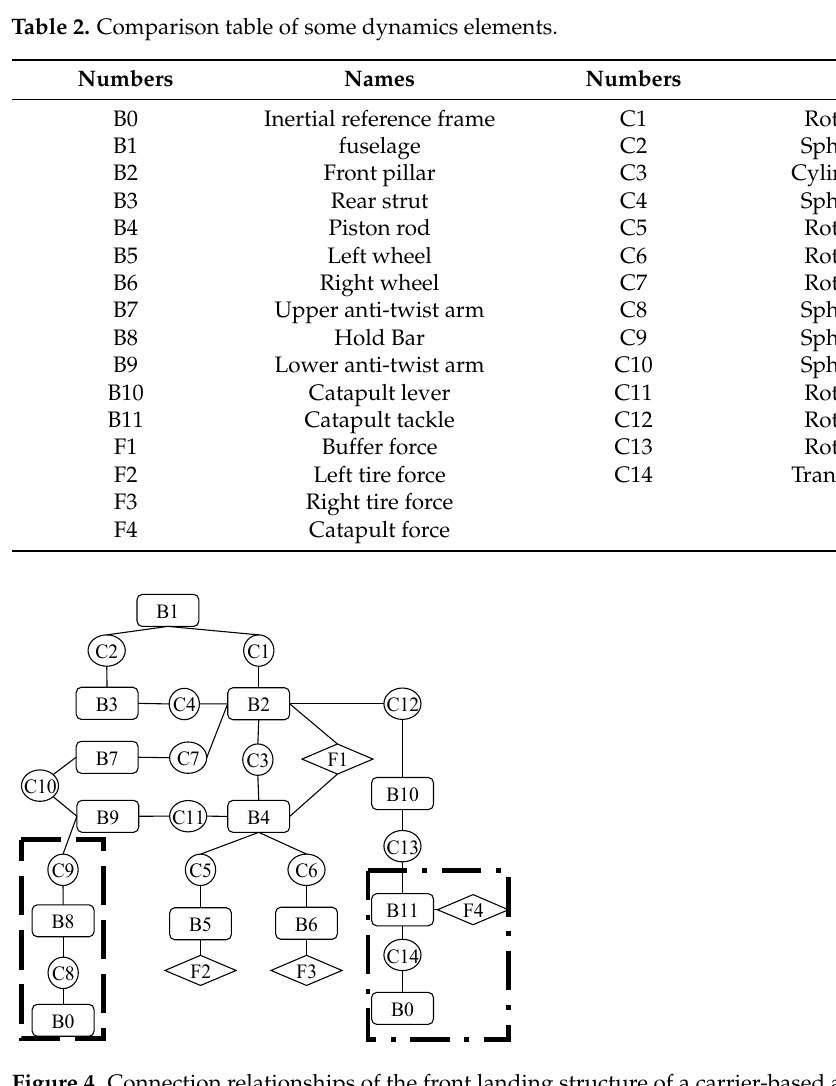
Table 2. Comparison table of some dynamics elements.